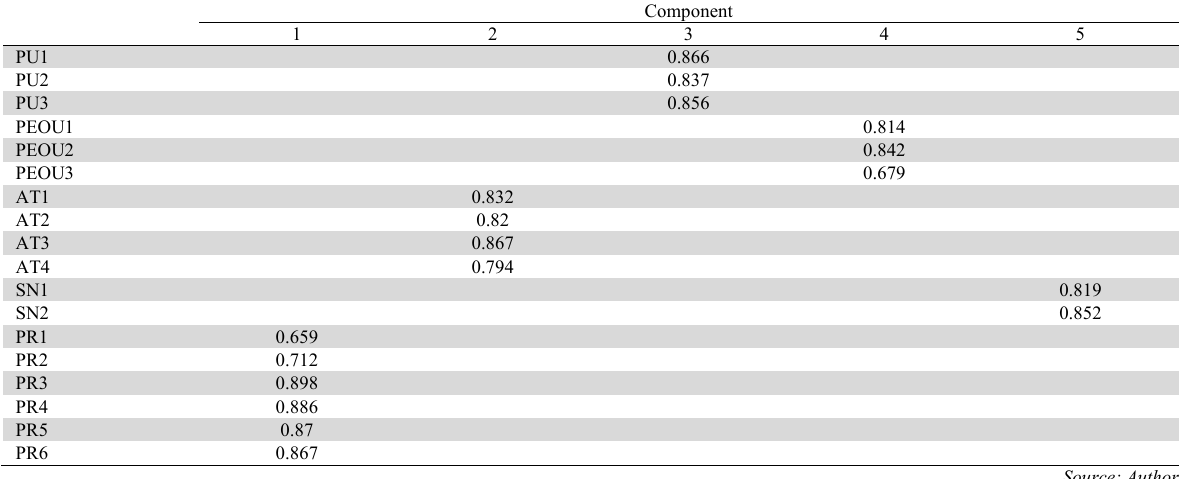
Rotated Component Matrix